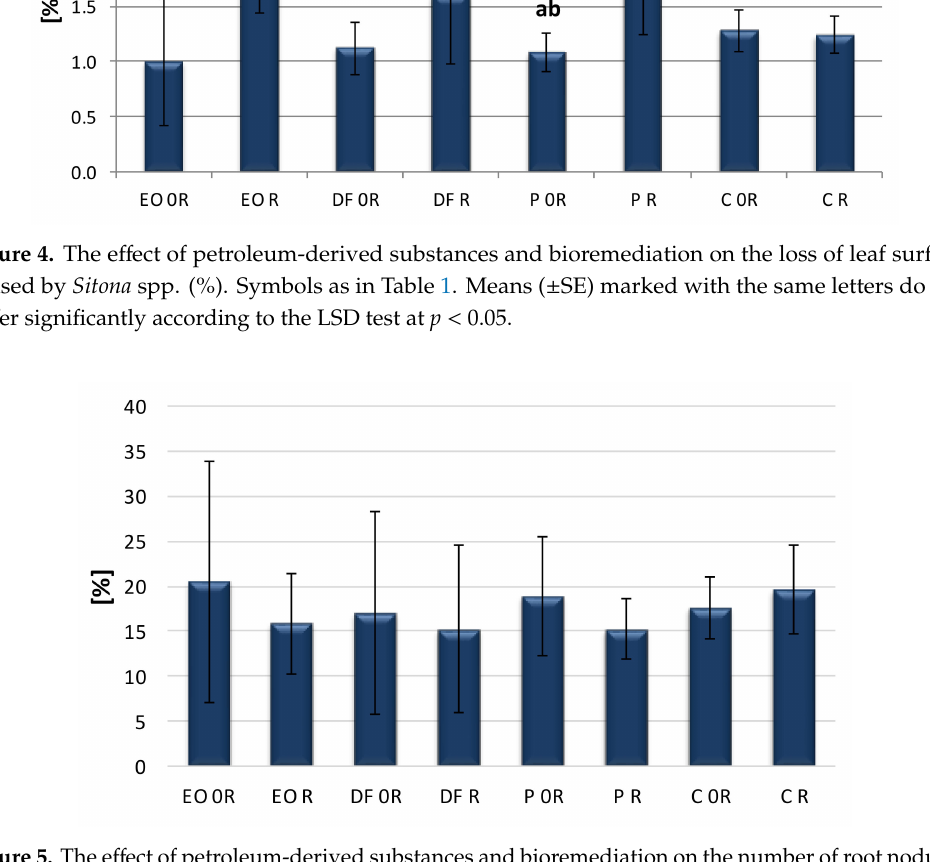
Figure 5. The e ff ect of petroleum-derived substances and bioremediation on the number of root nodules damaged by the larvae of Sitona spp. (%). Symbols as in Table 1. There were no statistically significant di ff erences between treatments. Vertical bars denote ±